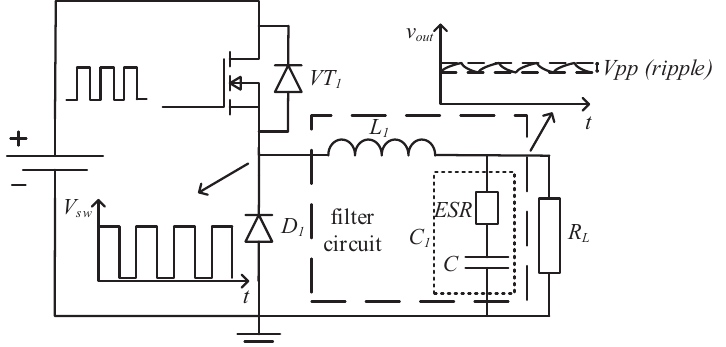
Figure 1. The occurrence of ripple in switched-mode power supply (SMPS) (taking buck topology as an